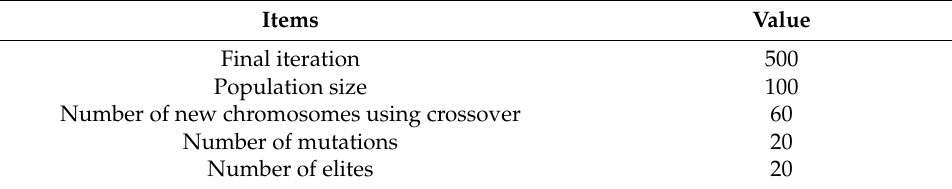
Table 7. The hyperparameters of the genetic algorithm used in the